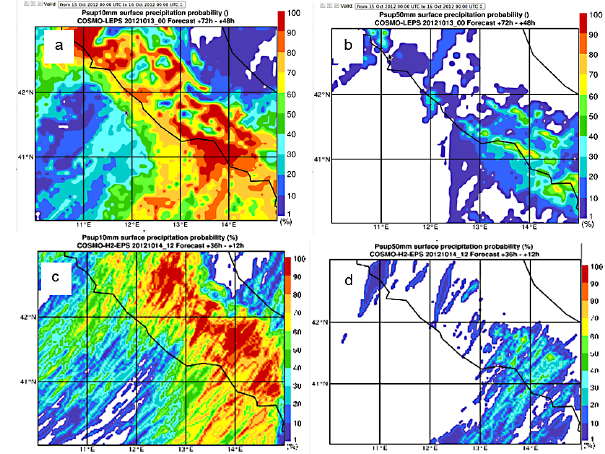
Figure 17. COSMO-LEPS (emission time: 00:00UTC of 13 Oc- tober 2012, fcst +48–72h) probability maps of 24h precipitation exceeding (a) 10mm and (b) 50mm. COSMO-H2-EPS (emission time: 12:00UTC of 14 October 2012, fcst +12–36h) probability maps of 24h precipitation exceeding (c) 10mm and (d)